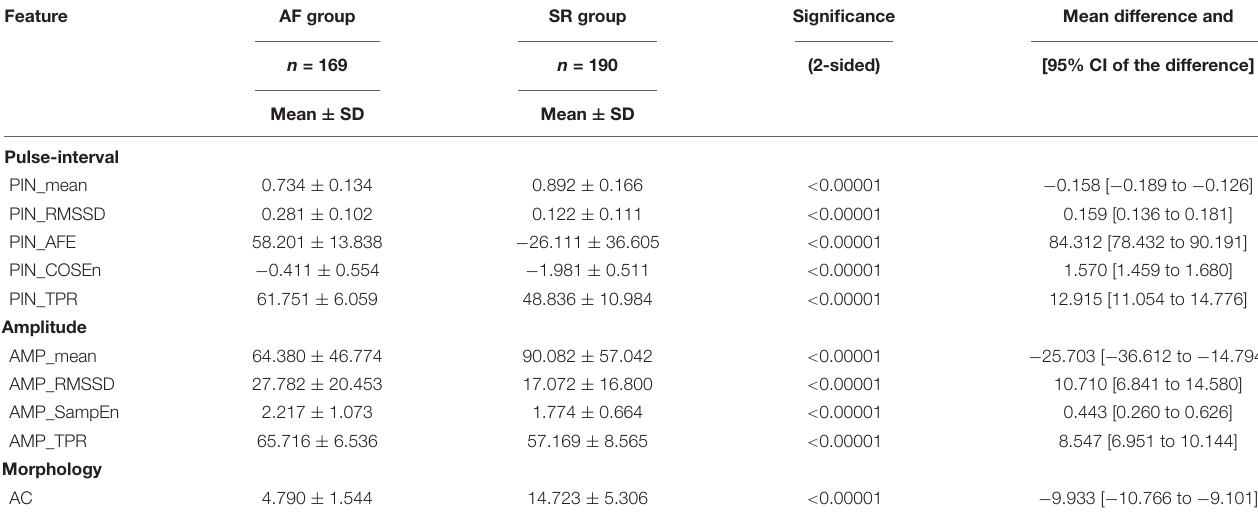
TABLE 2 | Comparison of feature parameter values between atrial fibrillation and sinus rhythm